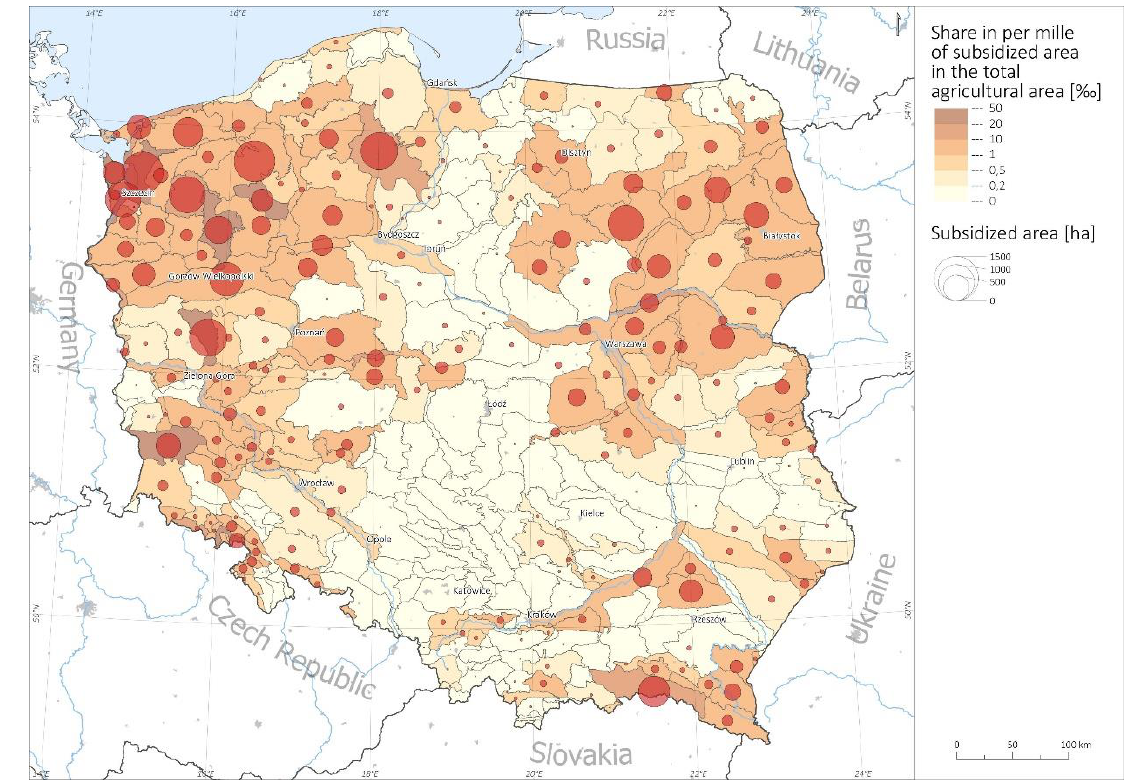
Figure 9. Area of land subsidised to support bird breeding habitats in special bird protection areas (SPAs), and their share in the total agricultural area in mesoregions (Source: Authors based on ARMA data).